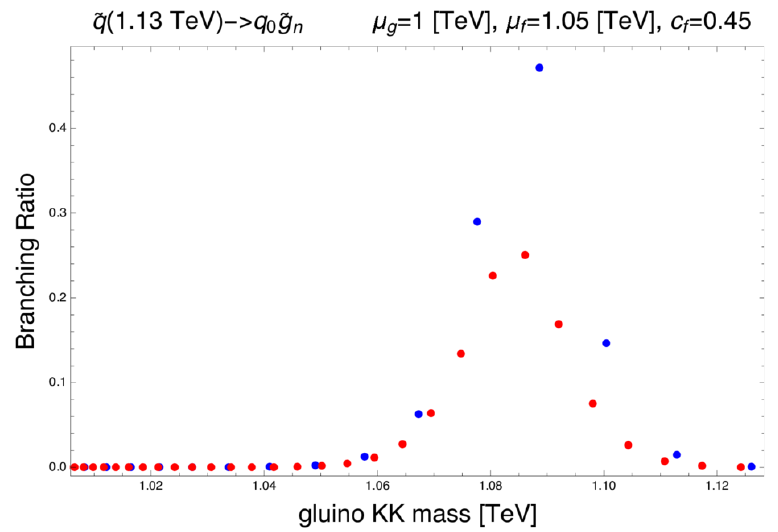
Figure 10. Examples of decay probabilities of a KK squark with mass > (cid:22) g , decaying to the zero mode quark and a lighter KK gluino. The BR is plotted for di(cid:11)erent choices of z IR : 0.1 GeV (cid:0) 1 (blue), and 0.2 GeV (cid:0) 1